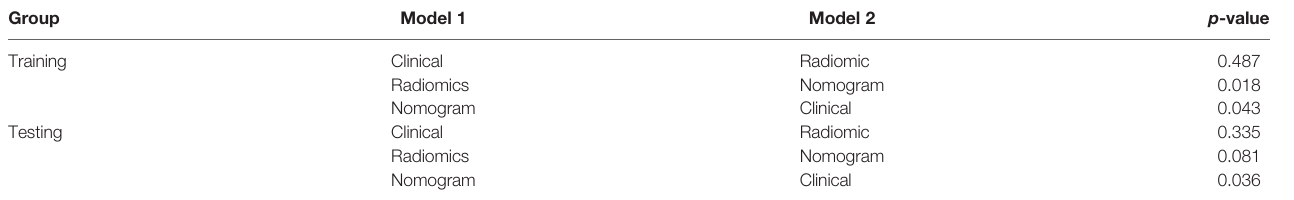
TABLE 3 | Comparison of the prediction with the radiomic nomogram, radiomic algorithm, and the clinical model. Group